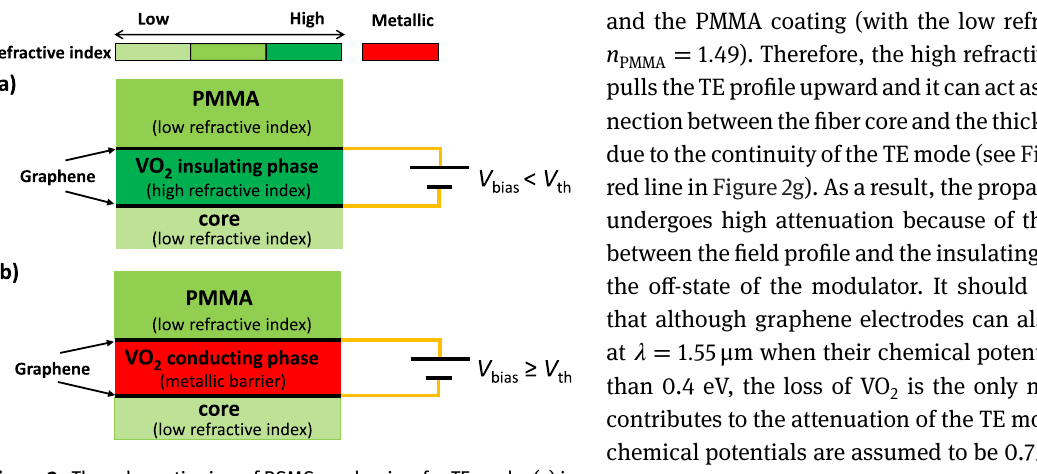
Figure 3: The schematic view of PSMS mechanism for TE mode, (a) in the insulating phase and (b) in the conducting